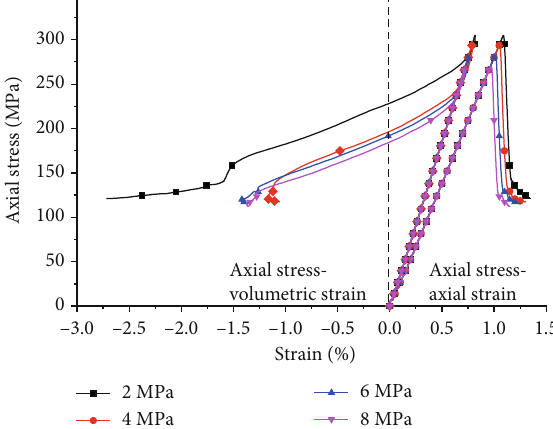
Figure 11: Simulated stress-strain curve for pore pressure of 8MPa under con fi ning pressure of